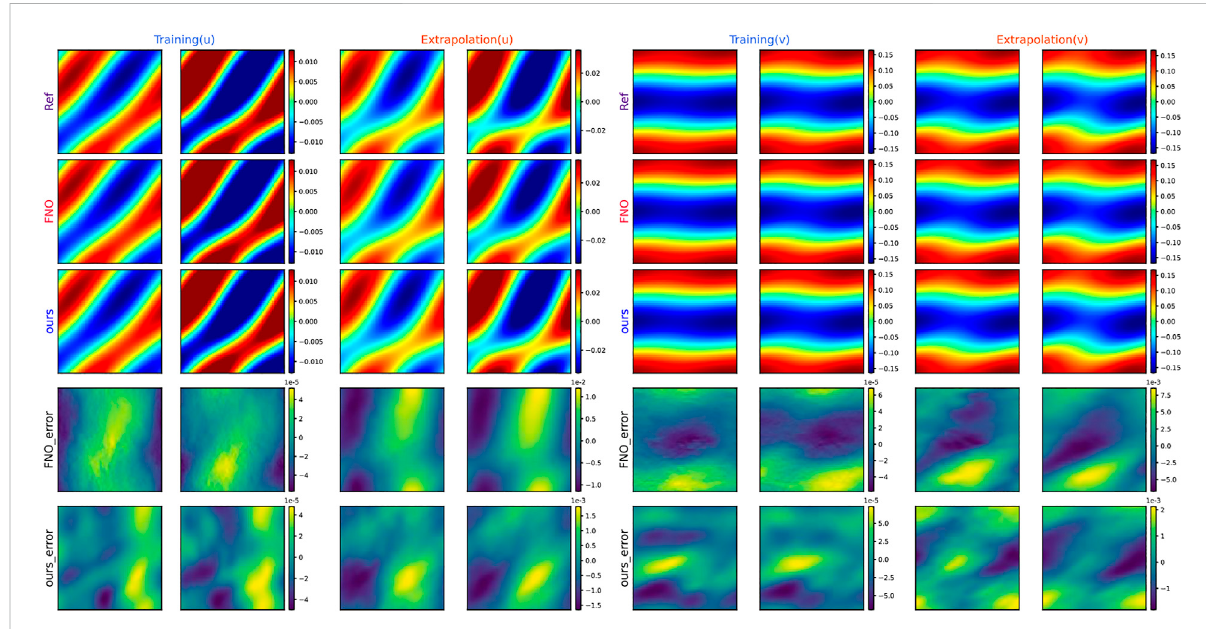
FIGURE 6 Velocity results of PA_CasualLSTM-solved 2D Navier – Stokes equation, four representative moments are selected as comparisons, namely, training ( t = 1, 1.7s) and extrapolation ( t = 2.5, 3.5s), and one-by-one errors over the entire interval are compared. The sub fi gures from top to bottom are reference solutions, predictions by FNO and PA_CasualLSTM, and errors of FNO and PA_CasualLSTM, respectively.